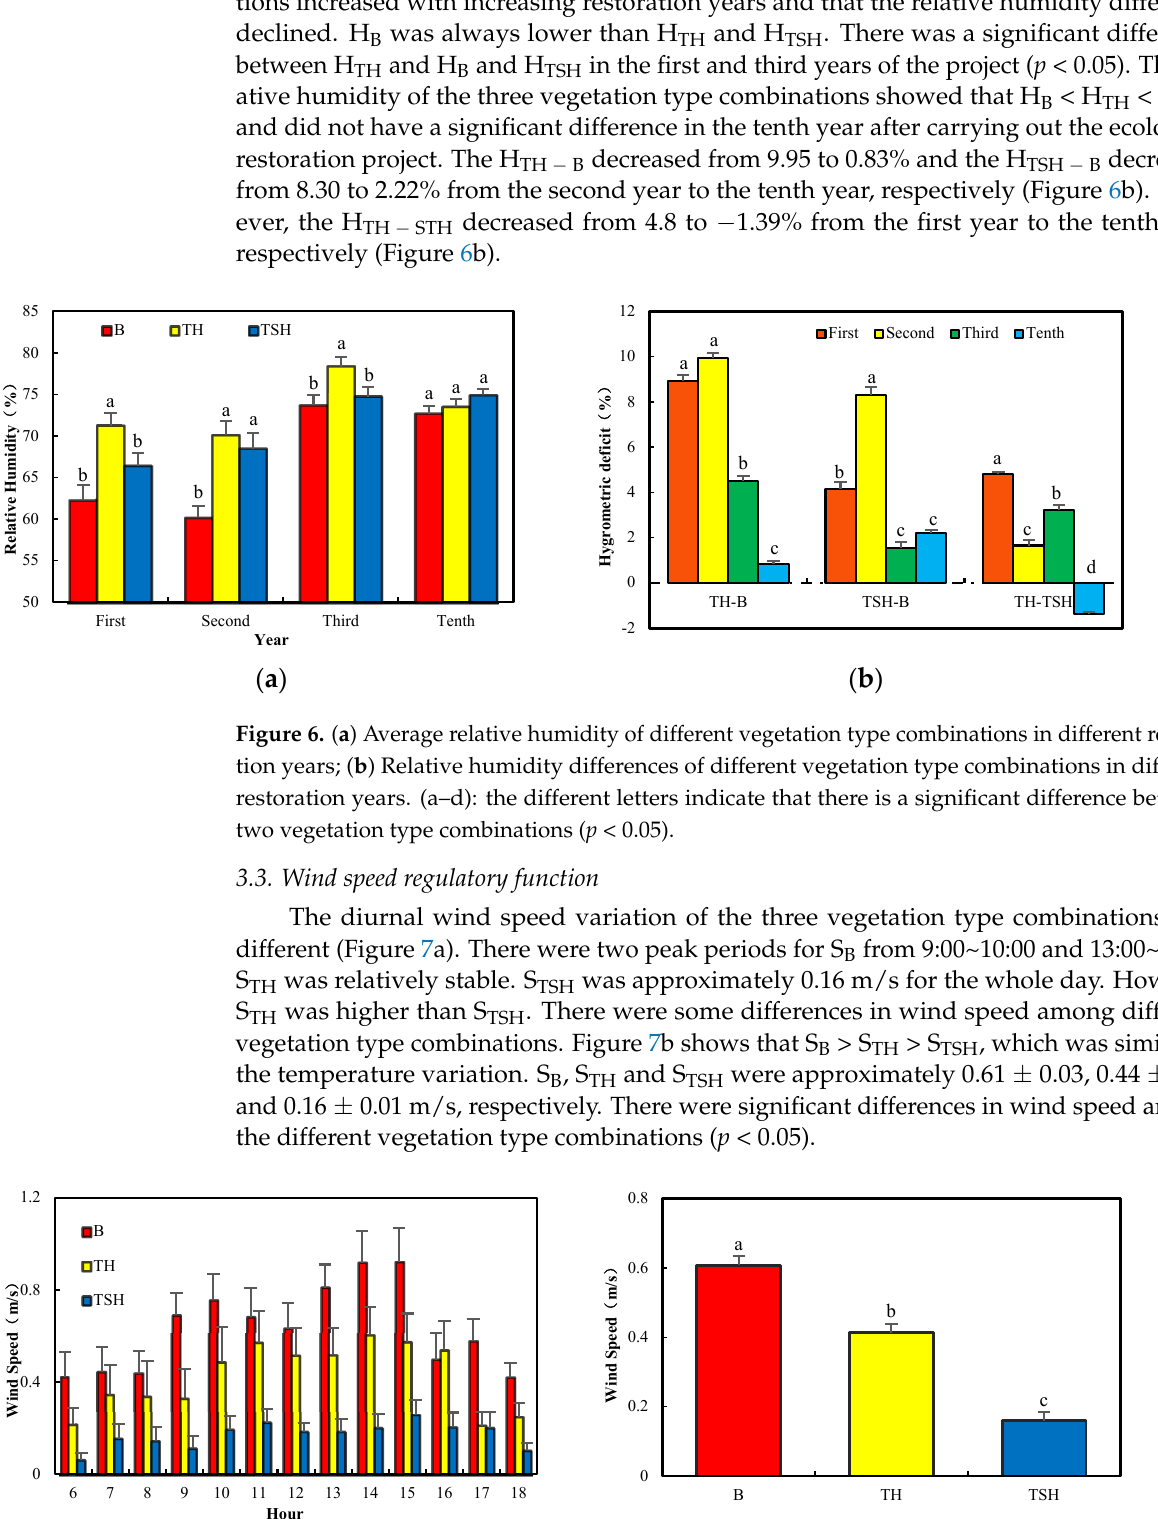
Figure 7. ( a ) Wind speed variations for each hour in different vegetation type combinations; ( b ) Average of diurnal wind speed in different vegetation type combinations. (a–c): the different letters indicate that there is a significant difference between two vegetation type combinations ( p < 0.05).